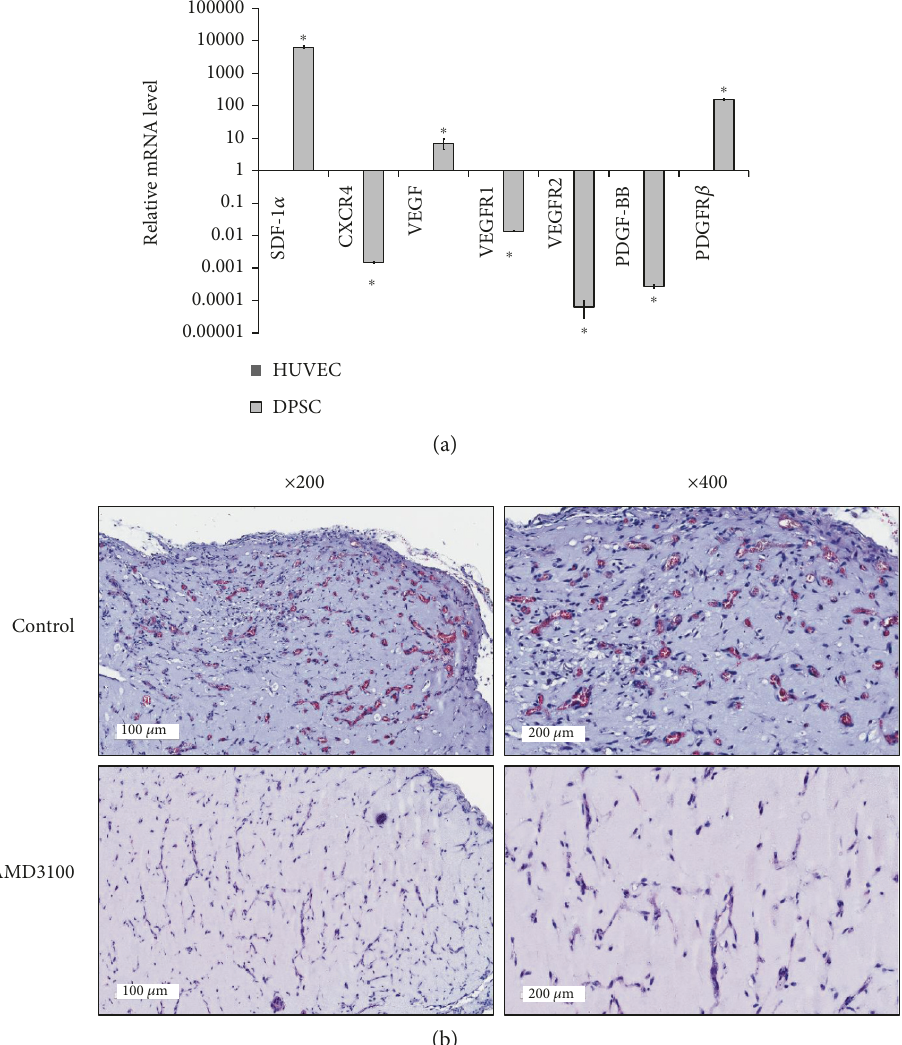
Figure 4: The involvement of SDF-1 α and CXCR4 axis in in vivo angiogenesis by DPSCs and HUVECs. The expression of angiogenic factors and receptors was veri fi ed by qPCR. (a) The expression of SDF-1 α , PDGFR β , and VEGF was higher in DPSCs than that in HUVECs. On the contrary, the expression of CXCR4 , PDGF-BB , VEGFR1 , and VEGFR2 was higher in HUVECs than that in DPSCs. ∗ p < 0 05 . (b) To con fi rm the functional involvement of SDF-1 α and CXCR4 axis in in vivo angiogenesis, AMD3100, an antagonist of CXCR4, was mixed with Matrigel plug. At 7 days postinjection, there were no microvessel-like structures in the AMD3100-treated group as compared to control